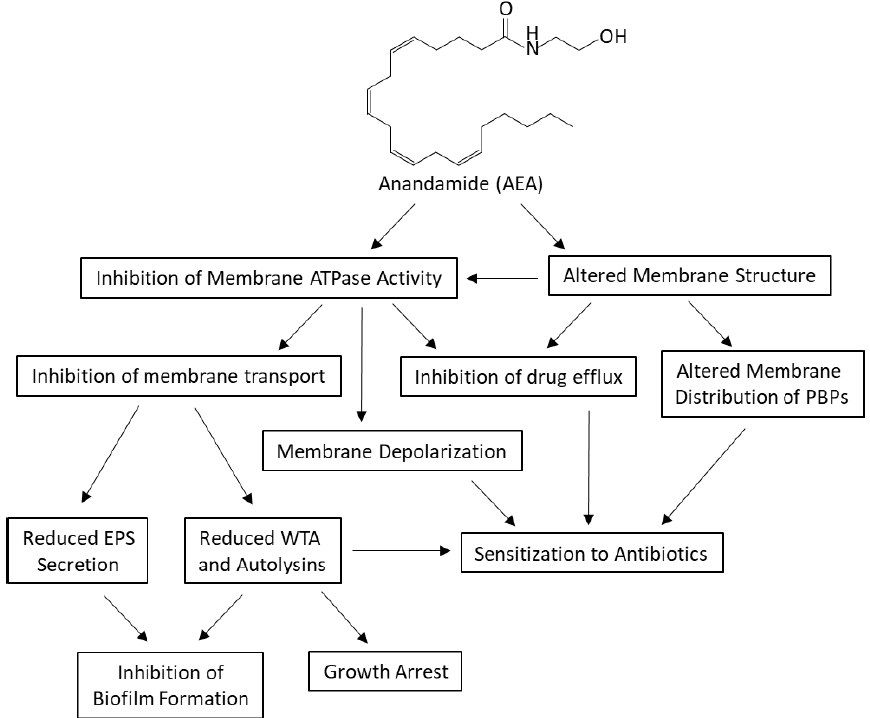
Figure 11. A summary of the characterized effects of AEA on multidrug resistant S. aureus . AEA is a bioactive lipid conjugate of the unsaturated arachidonic acid and ethanolamine. It causes alter- ations in the membrane structure and inhibition of membrane ATPase activities. As a result, the